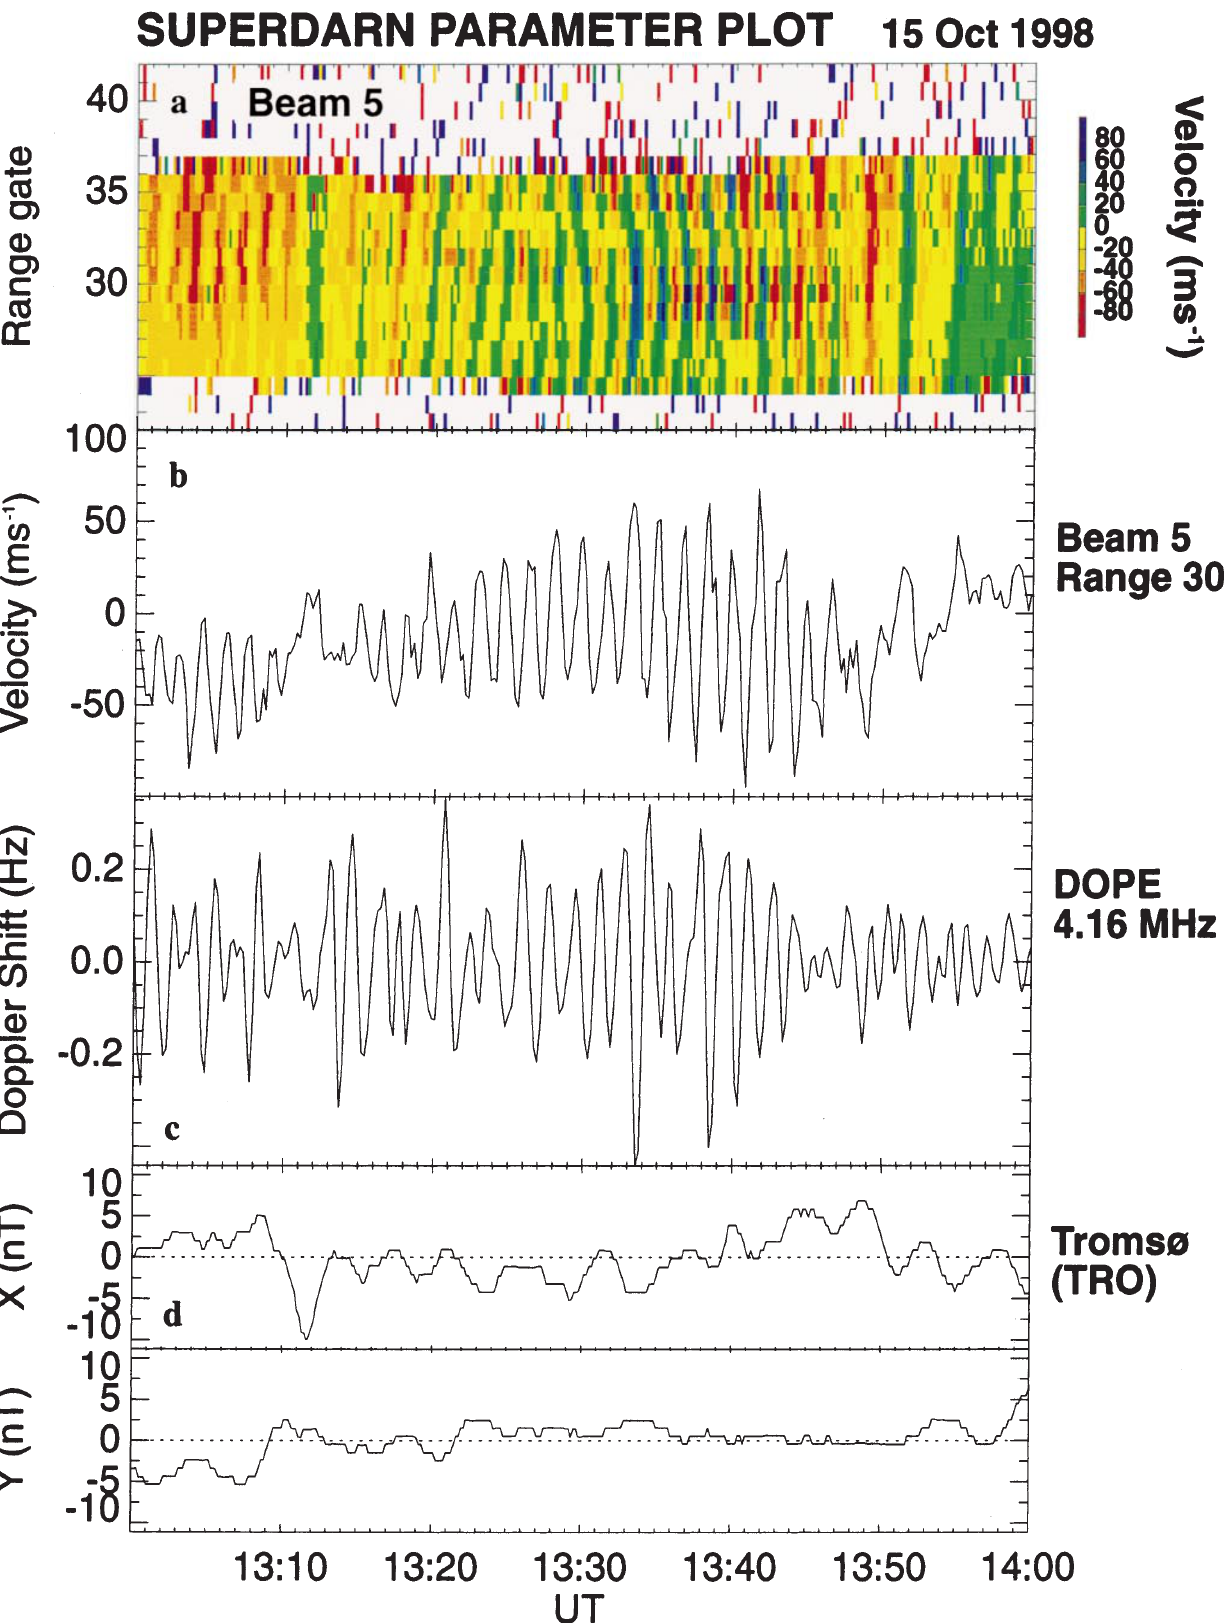
d Tromsø (TRO) X- and Y-component magnetic field. The data from the DOPE sounder has been filtered to exclude periods outside the range